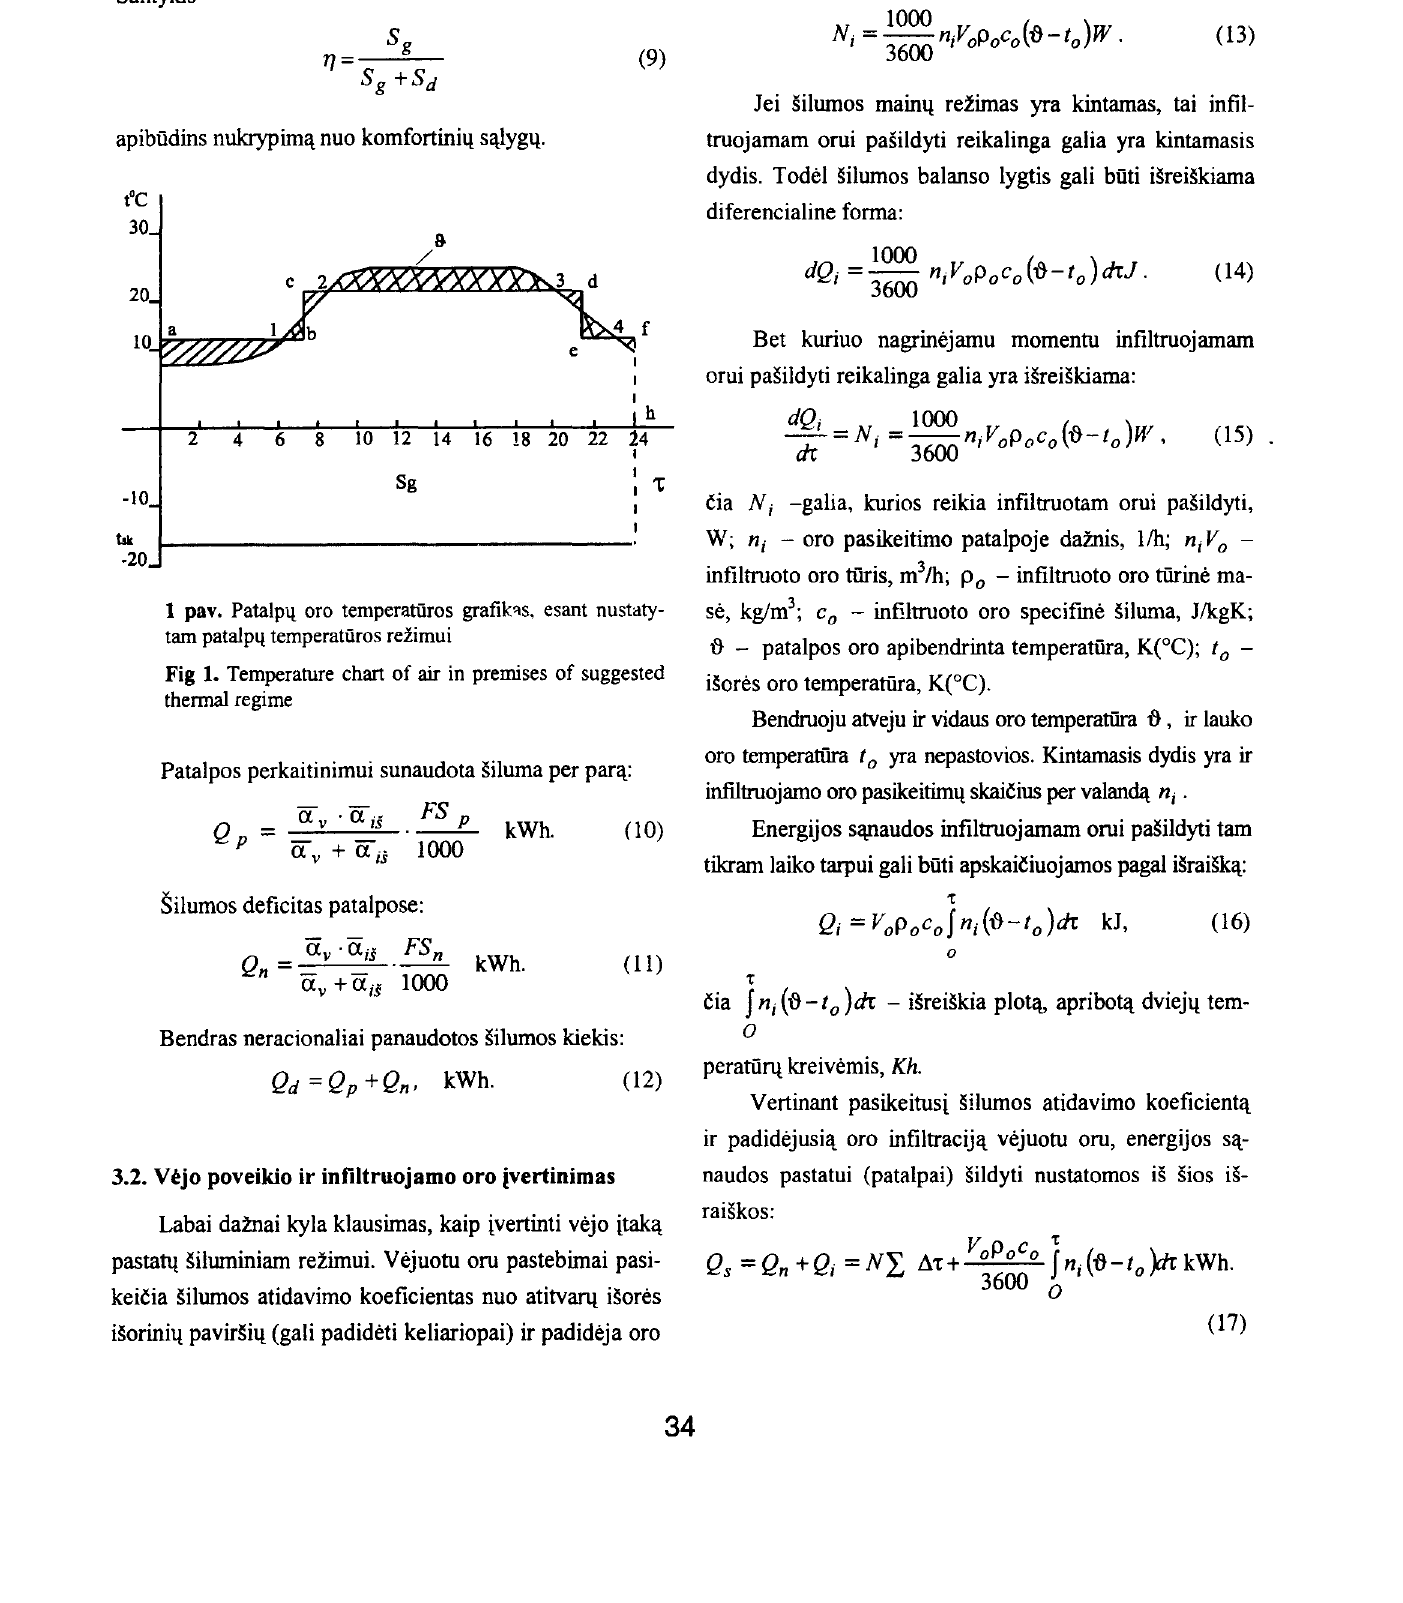
Fig 1. Temperature chart of air in premises of suggested thermal